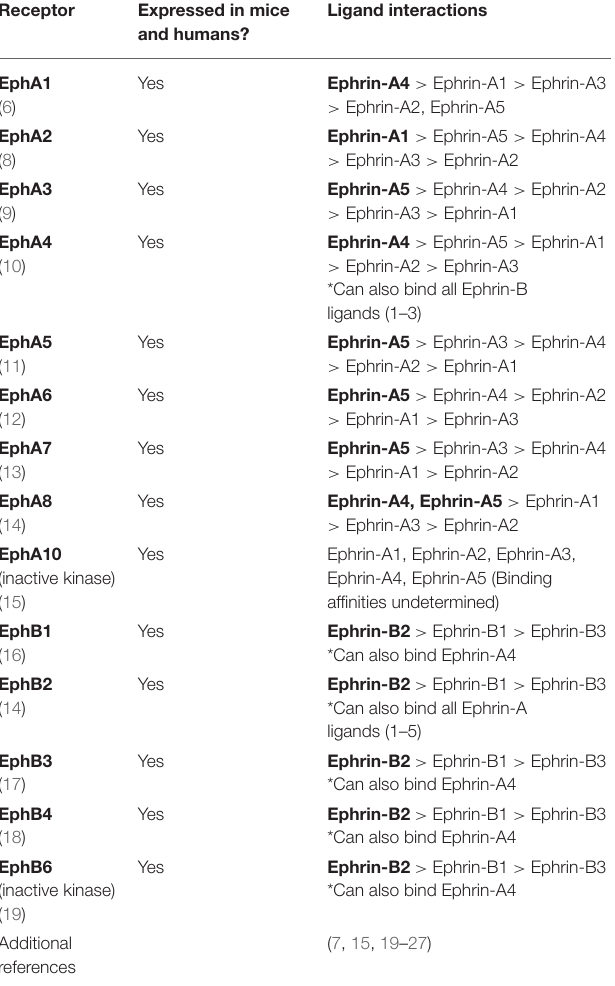
TABLE 1 | List of Eph receptors expressed in both mice and humans along with potential binding partners and preferences for ephrin ligands. Receptor Expressed in mice Ligand and humans?